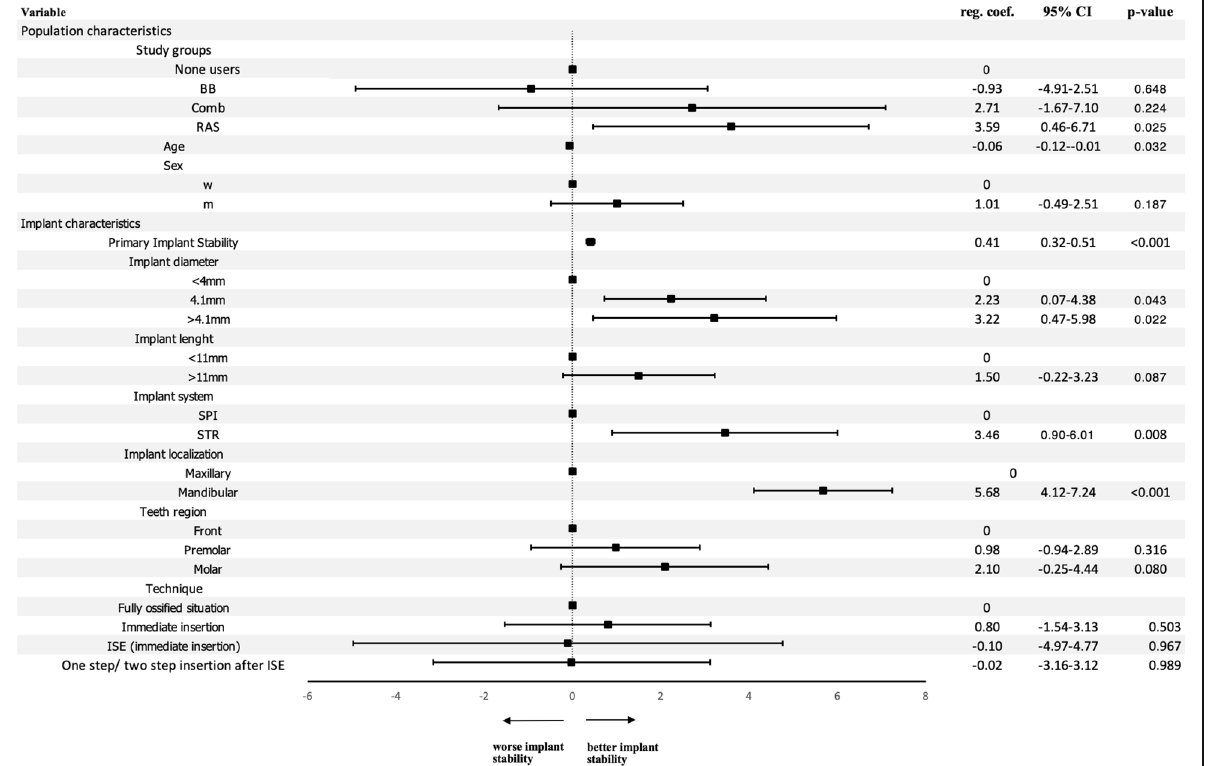
Fig. 4 Regression model of the implant stability quotient (ISQ) at implant exposure. BB, beta-blocker group; Comb, combined beta-blocker and RAS-inhibitor group; RAS, RAS inhibitor group; m, male; f, female; ISE, internal sinus elevation; STR, Straumann implants; SPI, Thommen implants; reg. coeff., regression coefficient; 95% CI, 95% confidence